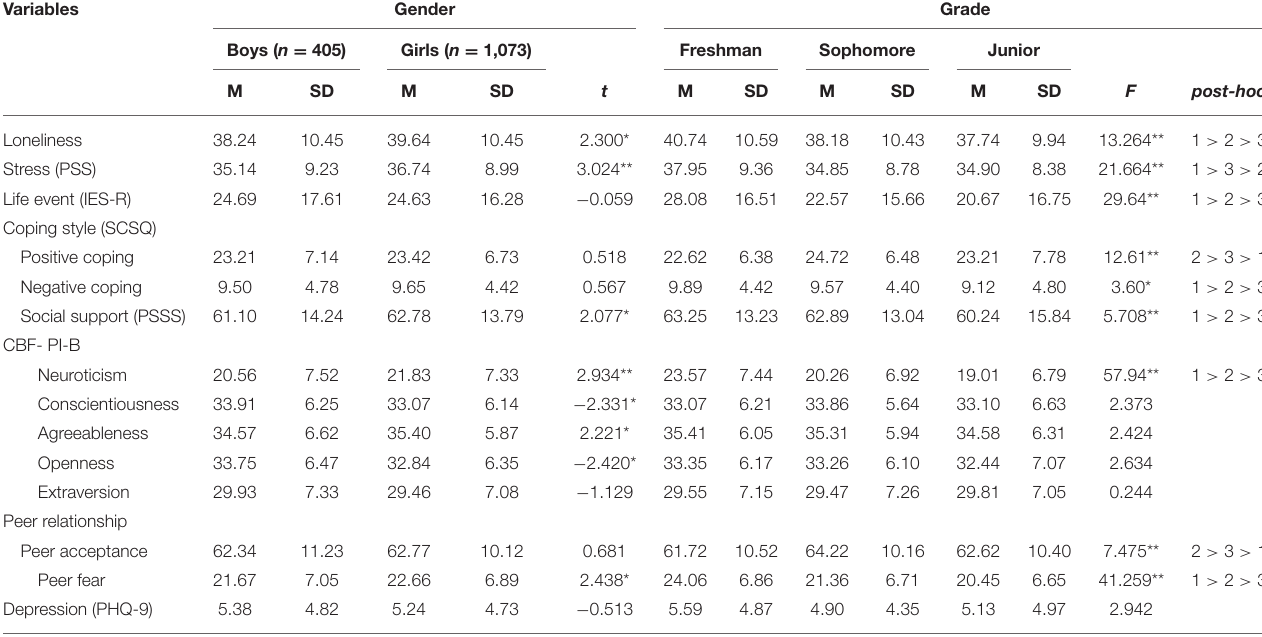
TABLE 2 | The differences of loneliness and psychosocial variables between genders and grades. Variables Gender